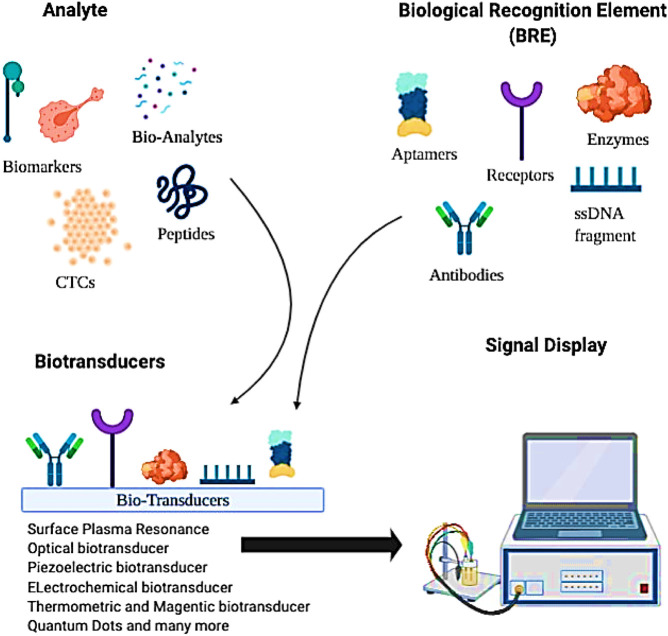
A schematic representation of a simple biosensor in detecting specific biomolecules such as cancer-specific biomarkers, shed-off extracellular domains, circulating tumor cells, etc., extracted from different body fluids.